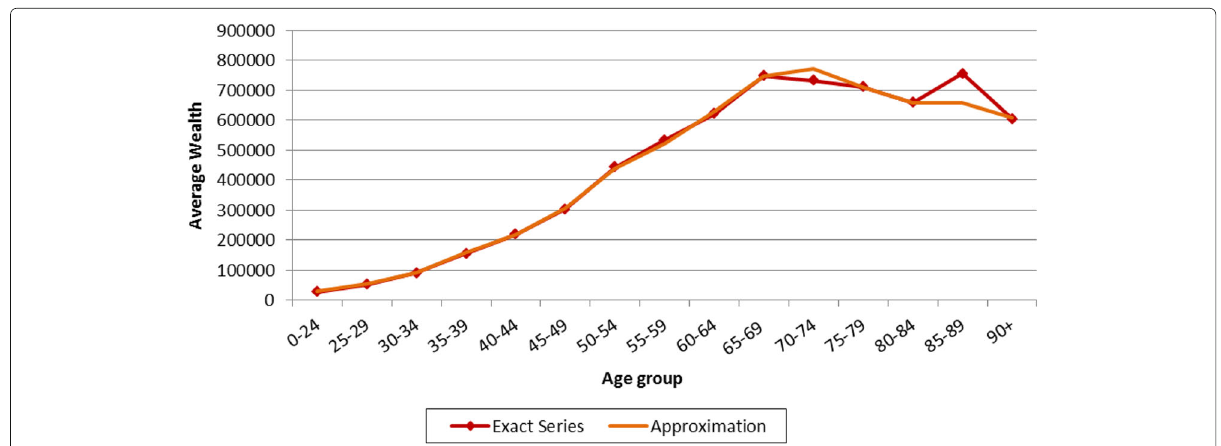
Fig. 9 Average age-wealth profiles of the living in 1995 (canton of Zurich). Notes: In 1995 Swiss francs. See text for data